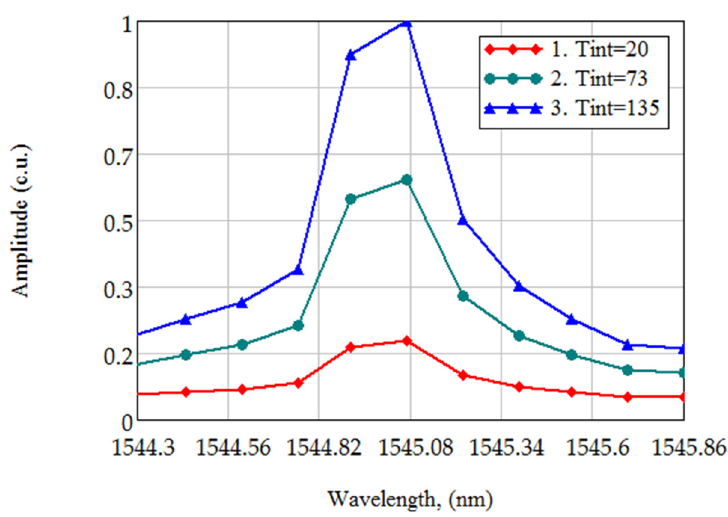
Figure 1. The FBG spectrum, measured at different TINT values (20, 73, 135 ms).